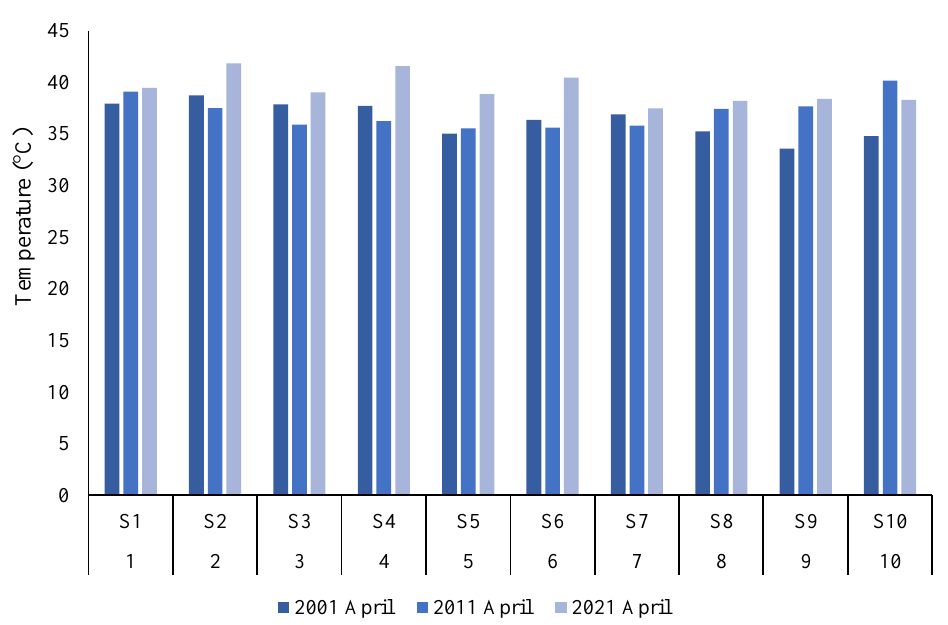
Figure 13. Land surface temperature assessment bar diagram of ten field reference locations of non-urbanized areas.